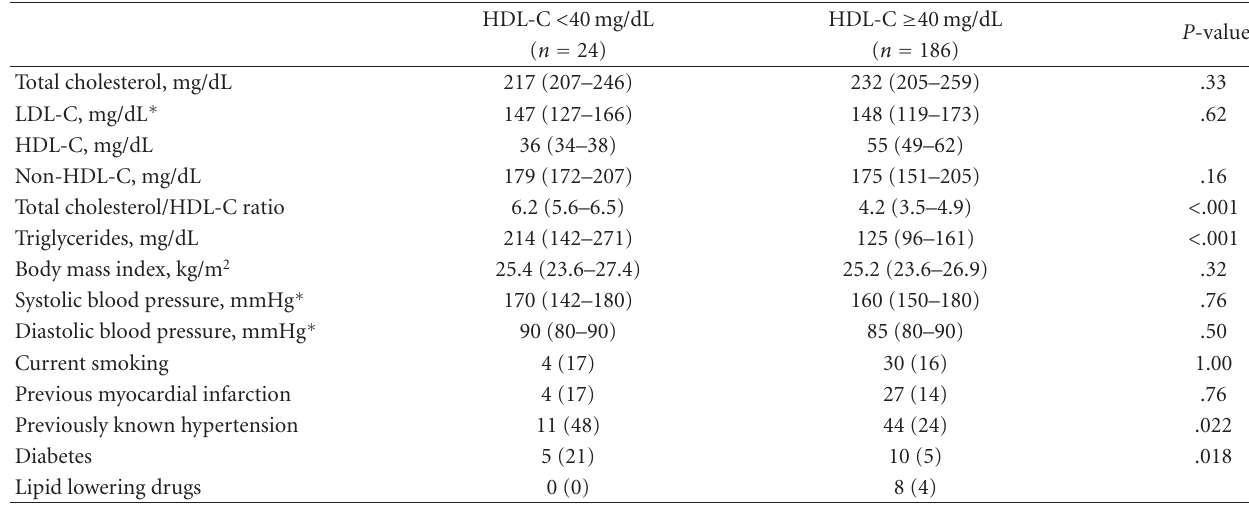
Table 3: Characteristics of the 75-year-old men with high or low HDL-C. Cuto ff level of HDL-C (40mg/dL) according to recommendation from the National Cholesterol Education Program—Adult Treatment Panel III. Values are median (interquartile range) and number